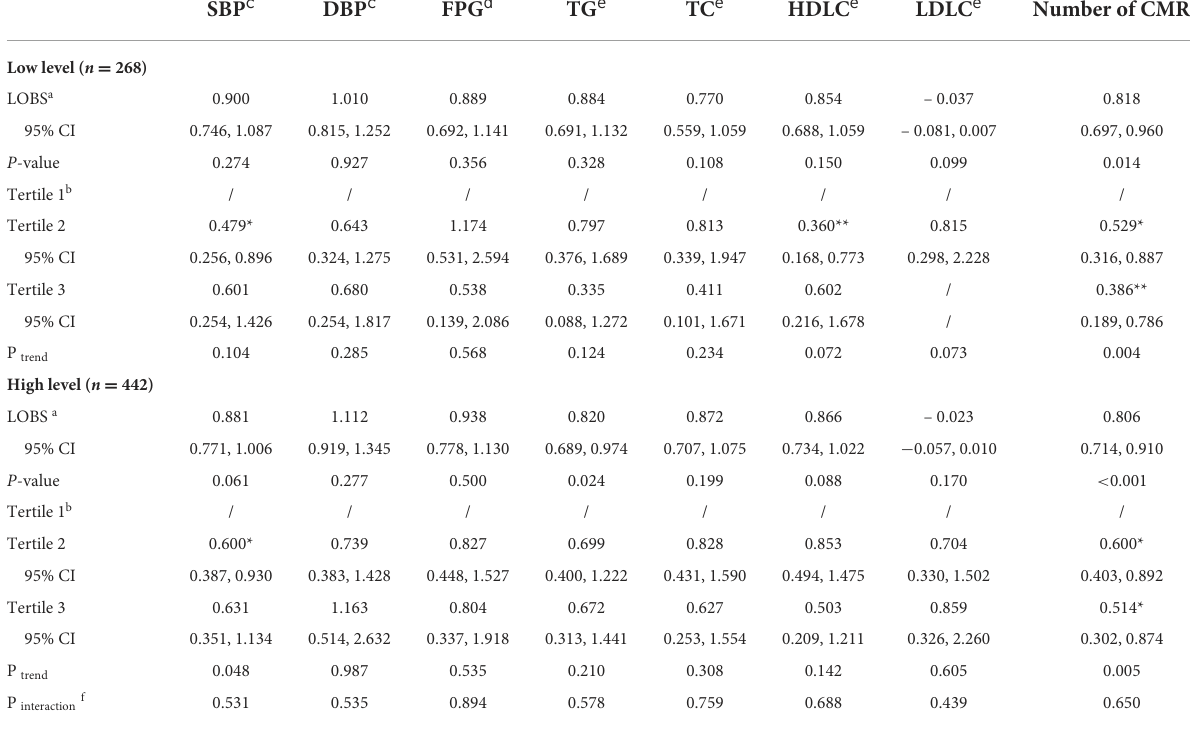
TABLE 6-2 Associations of the lifestyle-based oxidative balance score with the number of cardiometabolic risk factors and cardiometabolic biomarkers by socio-economic degree using logistic